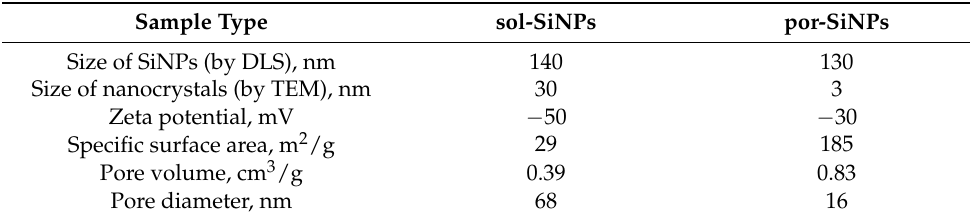
Table 1. Structural parameters of sol-SiNPs and por-SiNPs.